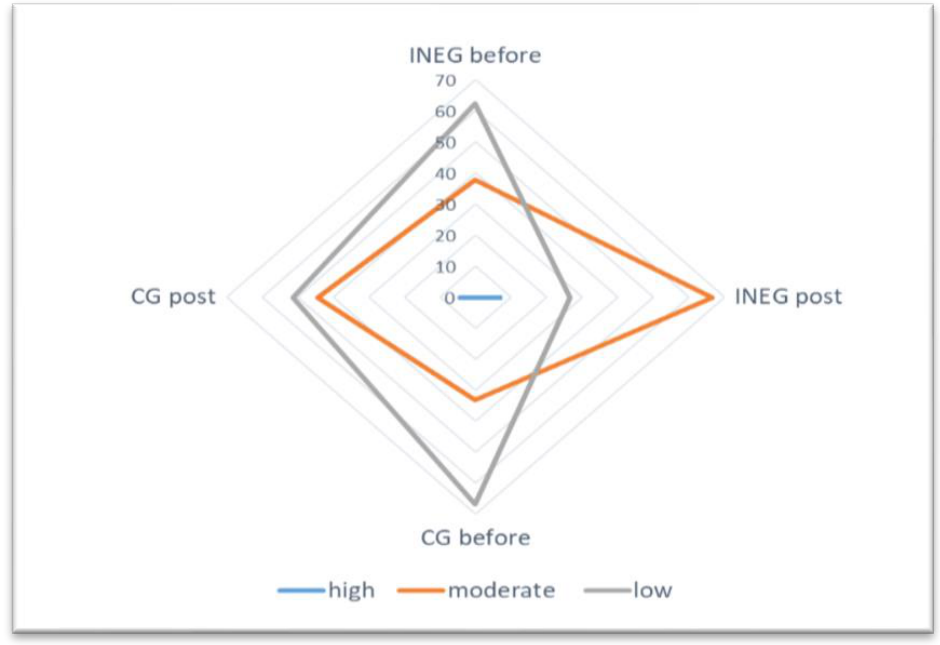
Figure 3. Assessment of physical activity among patients using the IPAQ questionnaire